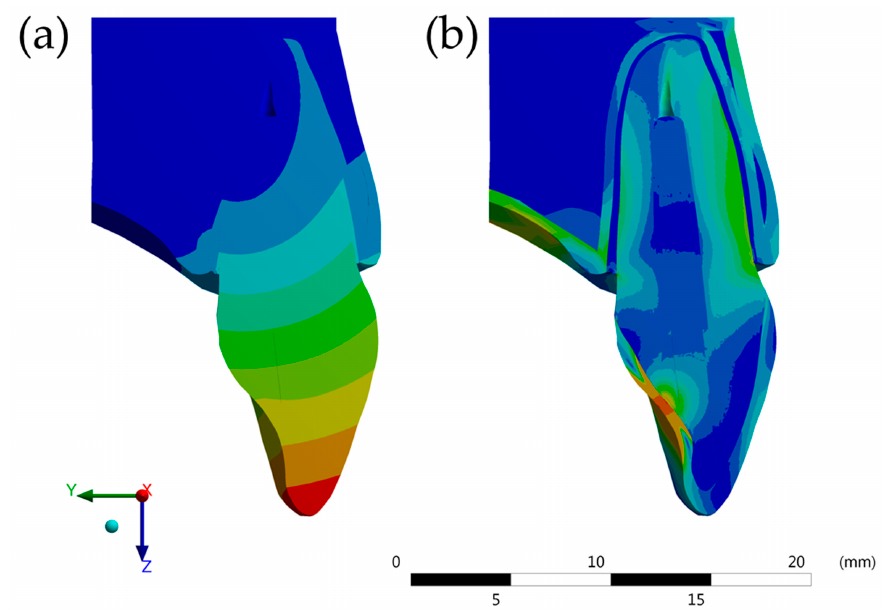
Figure 3. Meshing convergence representative results. ( a ) Total deformation and ( b ) von-Mises stress.